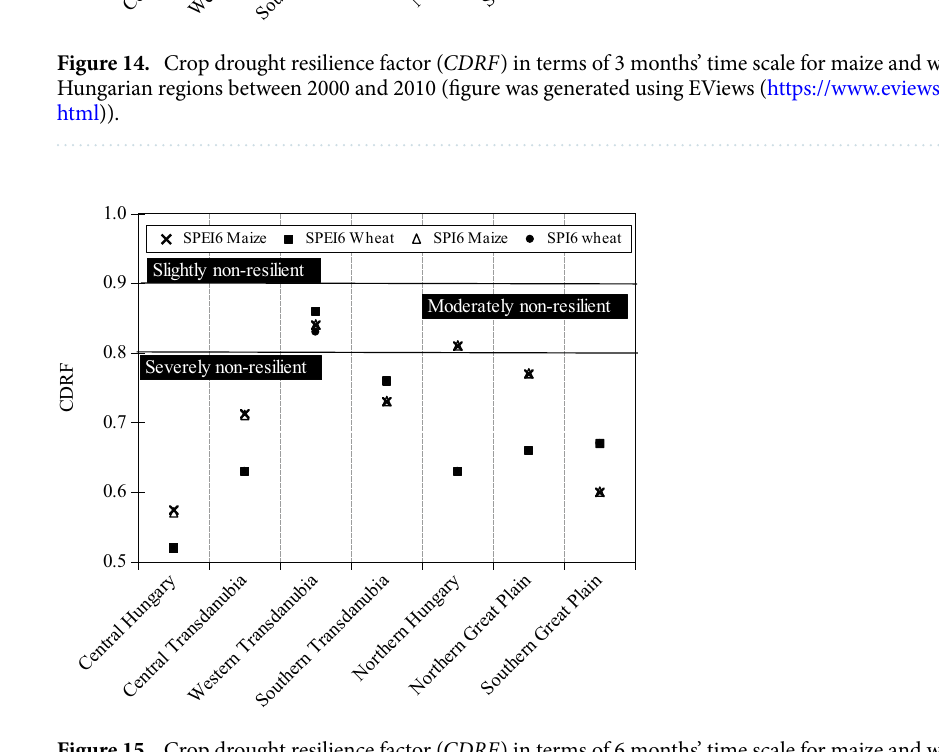
Figure 15. Crop drought resilience factor ( CDRF ) in terms of 6 months’ time scale for maize and wheat across Hungarian regions between 2000 and 2010 (figure was generated using EViews (https:// www. eviews. com/ home.